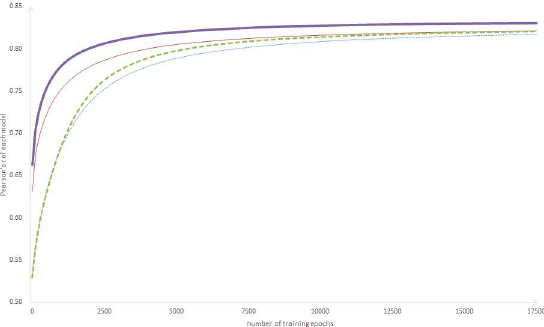
Fig 3. Change of Pearson’s r over training steps. The horizontal axis represents the number of training epochs, and the vertical axis represents Pearson’s r. The solid line indicates the model with pre-training, and the dashed line indicates the model without pre-training (the thick line indicates the D-LSTM, and the thin line indicates the MaLSTM).